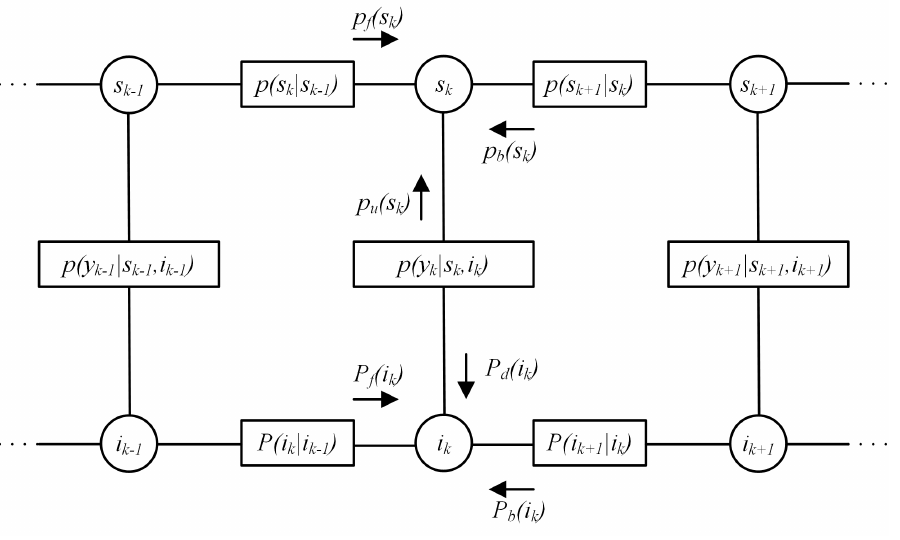
Figure 3. Factor graph representation of